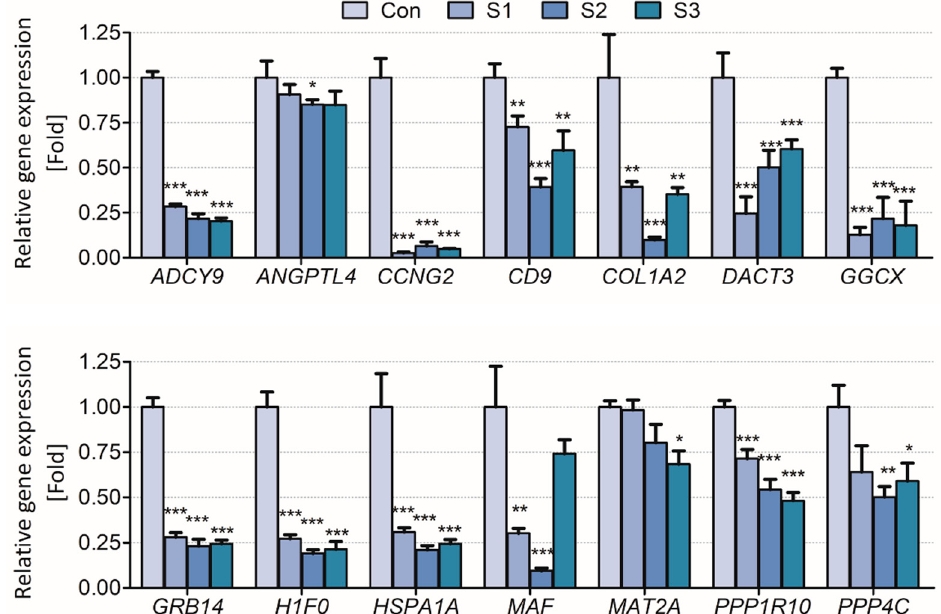
Figure 3. Validation of the candidate biomarkers of sodium thiocyanate exposure in BEAS-2B cells. Control (Con), vehicle; S1, 1 µ M; S2, 10 µ M; S3, 20 µ M of sodium thiocyanate. Each result is the mean ± SEM of ≥ three independent experiments. * p < 0.05, ** p < 0.01, *** p < 0.001.